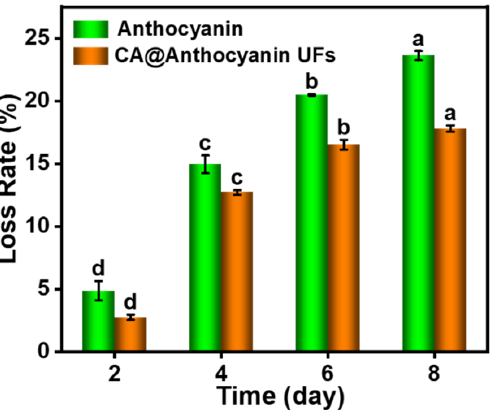
Figure 6. Loss rate of the anthocyanin and CA@Anthocyanin UFs under various natural light days. Note: Different letters (a, b, c, d) represent significant differences ( p < 0.05) between groups.